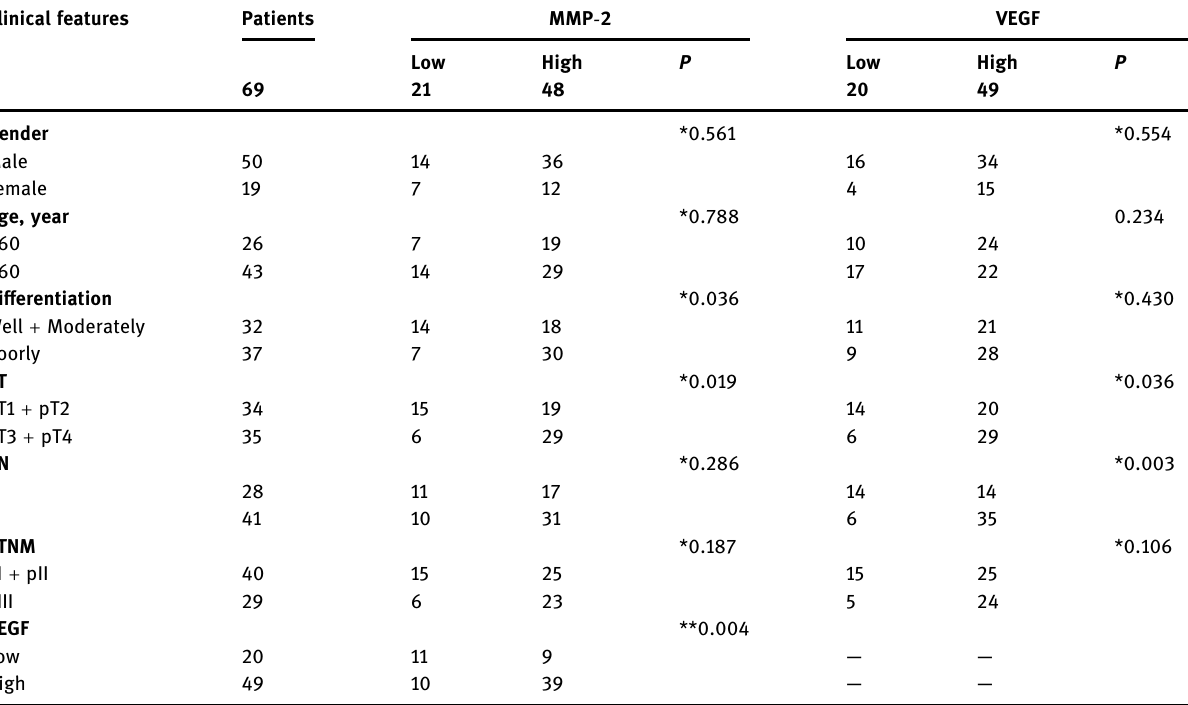
Table 1: Correlation between MMP - 2 and VEGF expression and clinicopathological features of the patients with adenocarcinoma of the esophagogastric junction Clinical